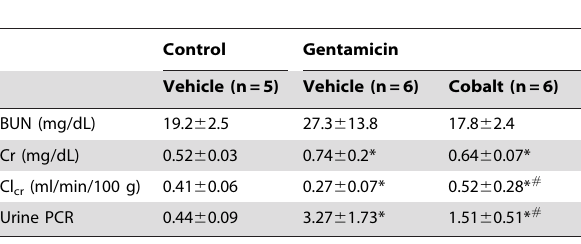
Table 1. Renal parameters of experimental